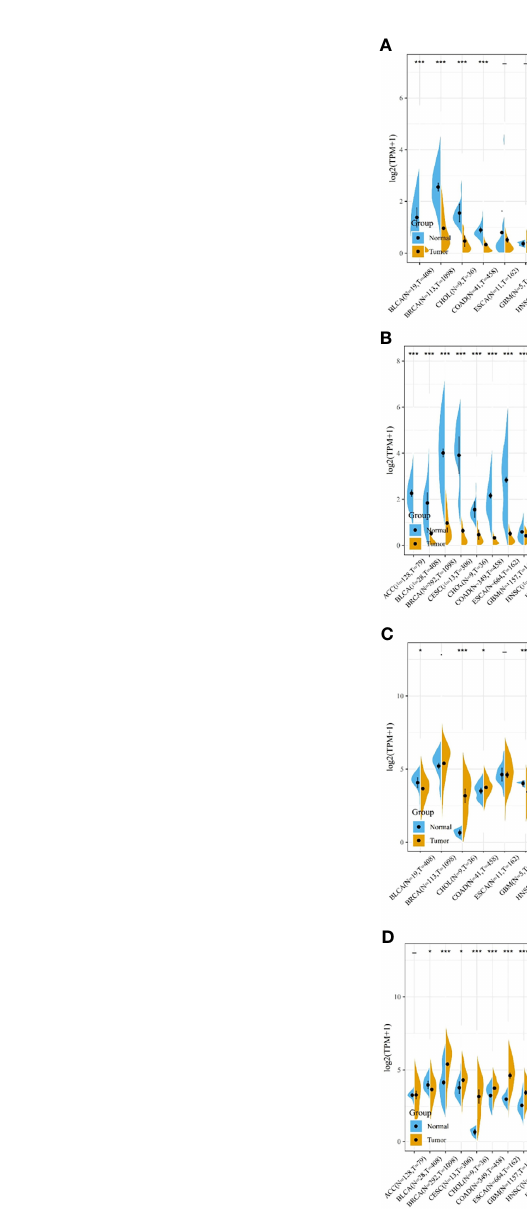
FIGURE 1 | IGF-1/IGF-1R expression levels in different types of human cancers. The expression levels of IGF-1 between tumor and normal tissues were compared in 20 cancer types based on the TCGA database (A) and 27 cancer types based on the integrated database from TCGA and GTEx datasets (B) . The expression levels of IGF-1R between tumor and normal tissues were compared in 20 cancer types based on the TCGA database (C) and 27 cancer types based on the integrated database from TCGA and GTEx datasets (D) . Consistent high expression level of IGF-1 could be seen in normal tissues than most types of tumor based on both comparisons, and signi fi cant decreased expression of IGF-1 could be seen in tumor samples including ACC, BLCA, BRCA, CESC, CHOL, COAD, ESCA, LAML, LGG, LIHC, LUAD, OV, PRAD, READ, SKCM, STAD, TGCT, THCA, UCEC, and UCS based on the integrated database. Consistent high expression level of IGF-1R could be seen in most types of tumor than normal tissue based on the both comparisons, and signi fi cant increased expression of IGF-1R could be seen in tumor samples including BRCA, CHOL, COAD, ESCA, GBM, HNSC, LAML, LGG, LIHC, LUAD, LUSC, PAAD, PRAD, SKCM, STAD, TGCT, and THCA based on the integrated database. “ *, **, *** ” means p < 0.05, p < 0.01 and p < 0.001,